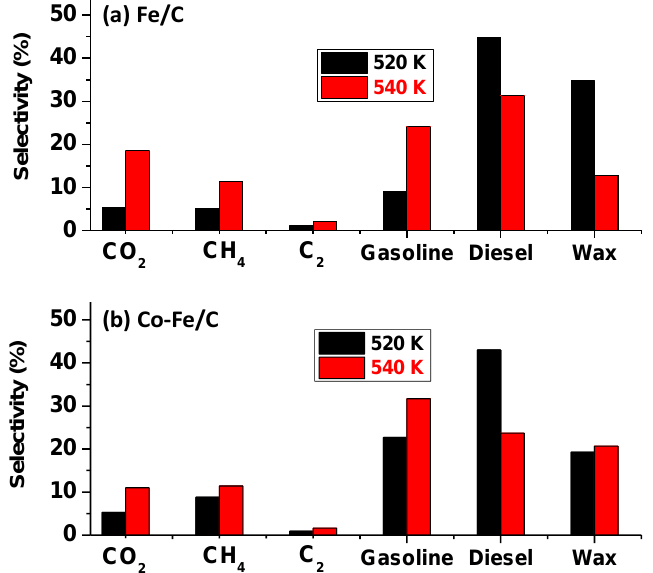
Figure 7. The aggregate selectivity of ( a ) Fe/C and ( b ) Co-Fe/C catalysts tested at 520 K and 540 K (pressure = 2 MPa; GHSV = 2000 cm 3 h − 1 g − 1 of the catalyst).